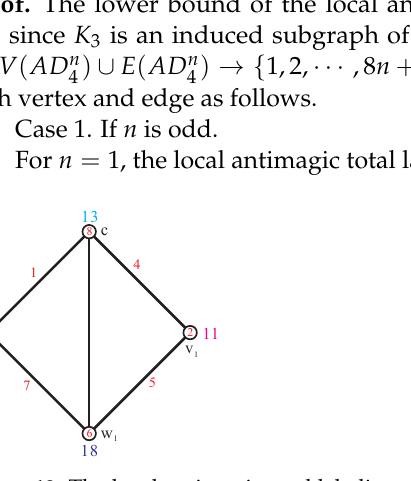
Figure 12. The local antimagic total labeling of AD 1